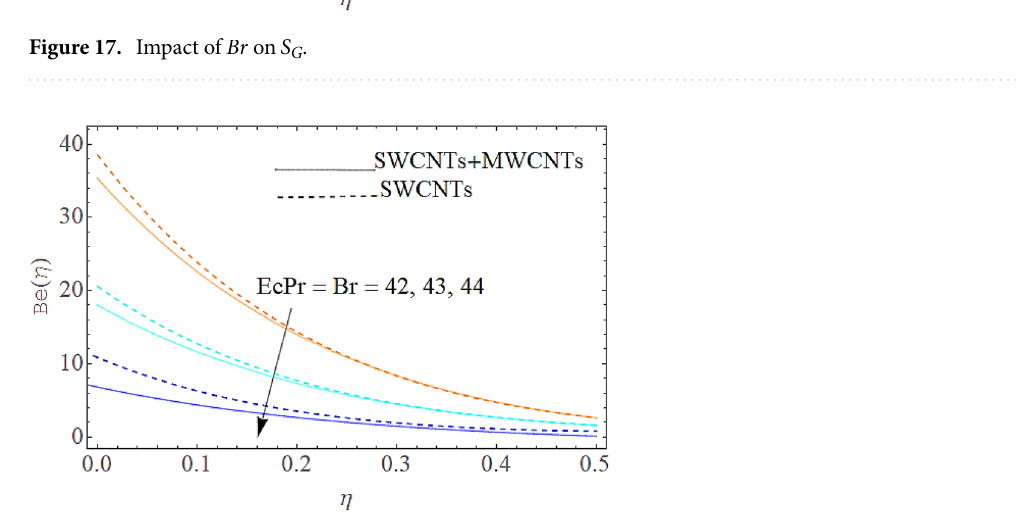
Figure 18. Outcome of Br on Be